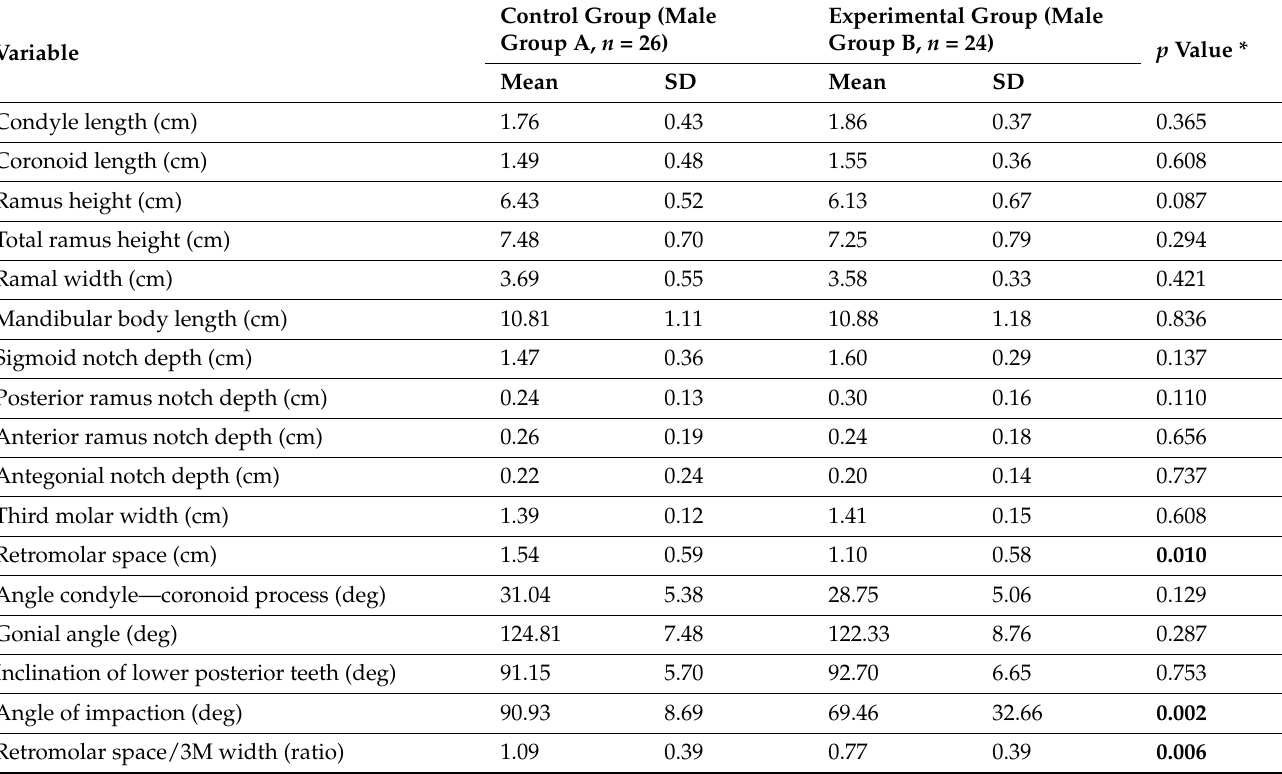
Table 3. Comparison between male group A (MA) and the male group B